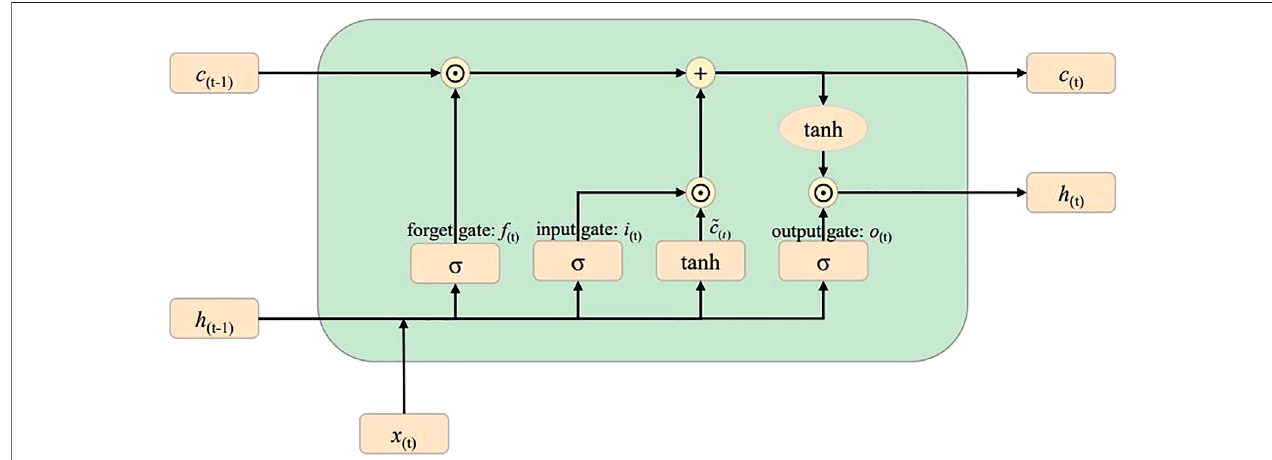
FIGURE 1 | Structure of the